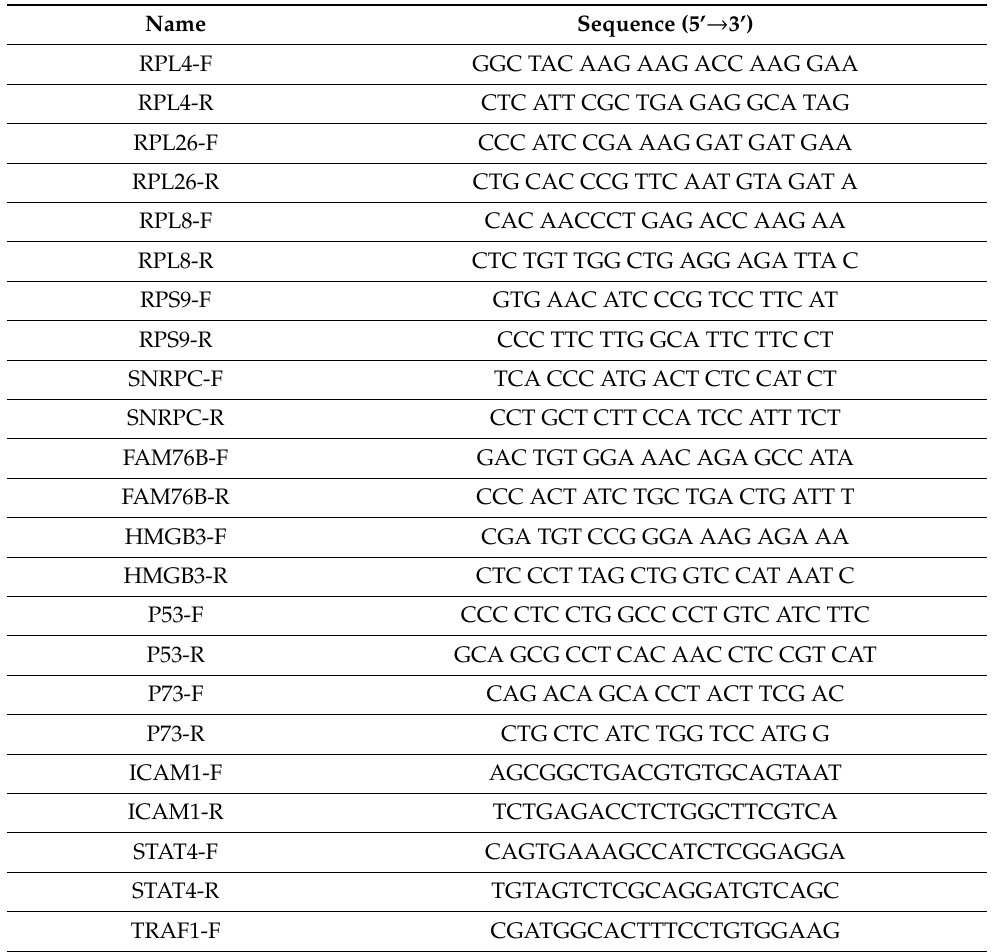
Figure A3. Western blots showing downregulation of CD40 and ICAM1 in FLS used for scratch-wound assay in Figure 5C. Table A1. Primers used in this